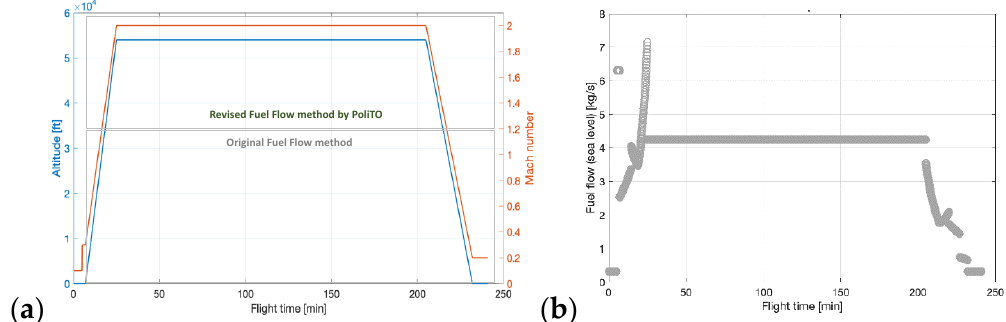
Figure 9. Reference Concorde mission ( a ) and reference fuel-flow values reported at sea level conditions ( b ).